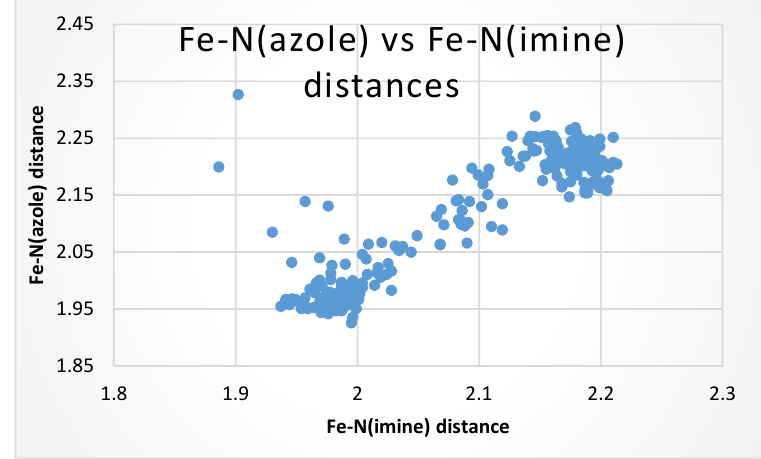
Figure 8. Scatterplot of the Fe-N imine (x axis) vs. Fe-N azole (y axis) bond distances of the 83 cationic compounds of a SB of tren condensed with a 5 membered azole carboxaldehyde. R 2 = 0.806.